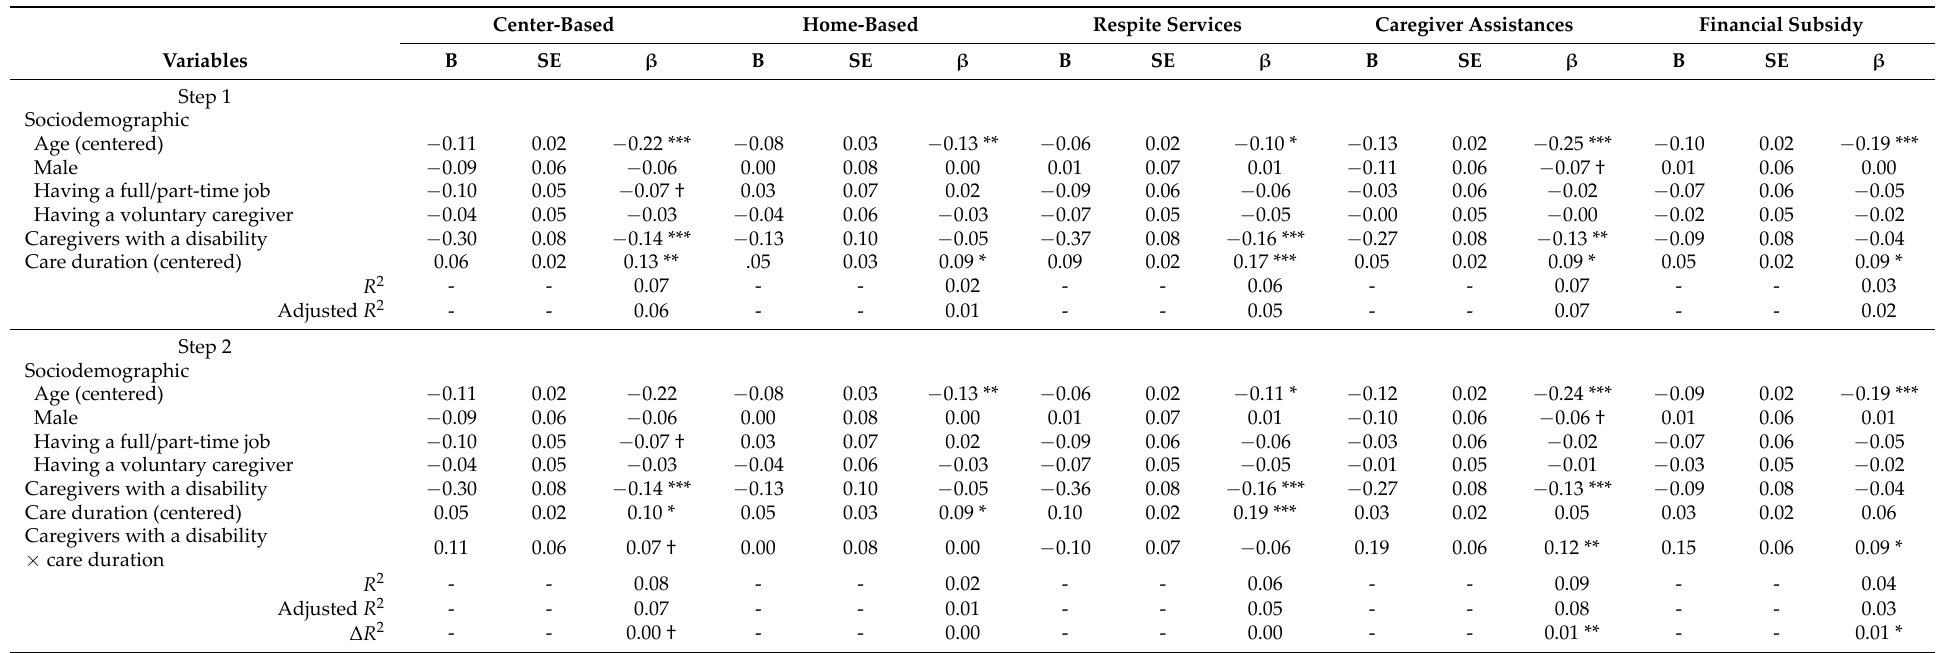
Table 3. Multiple regression models ( n =